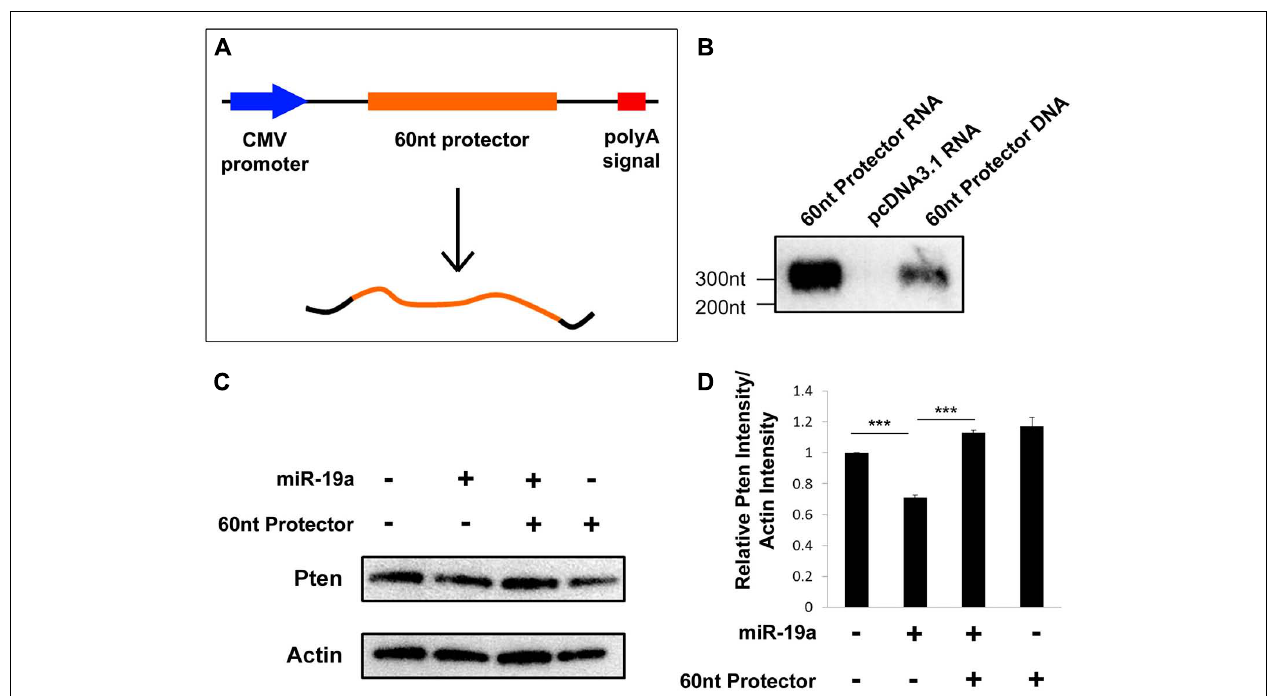
levels of Pten were decreased upon transfection of miR-19a but recovered upon cotransfection of miR-19a and the 60 nt target protector.Transfection of the 60 nt target protector alone also showed an increase in Pten. Data are presented as mean ± SD; n = 3 separate protein extractions; p values in relation to control (*** p <